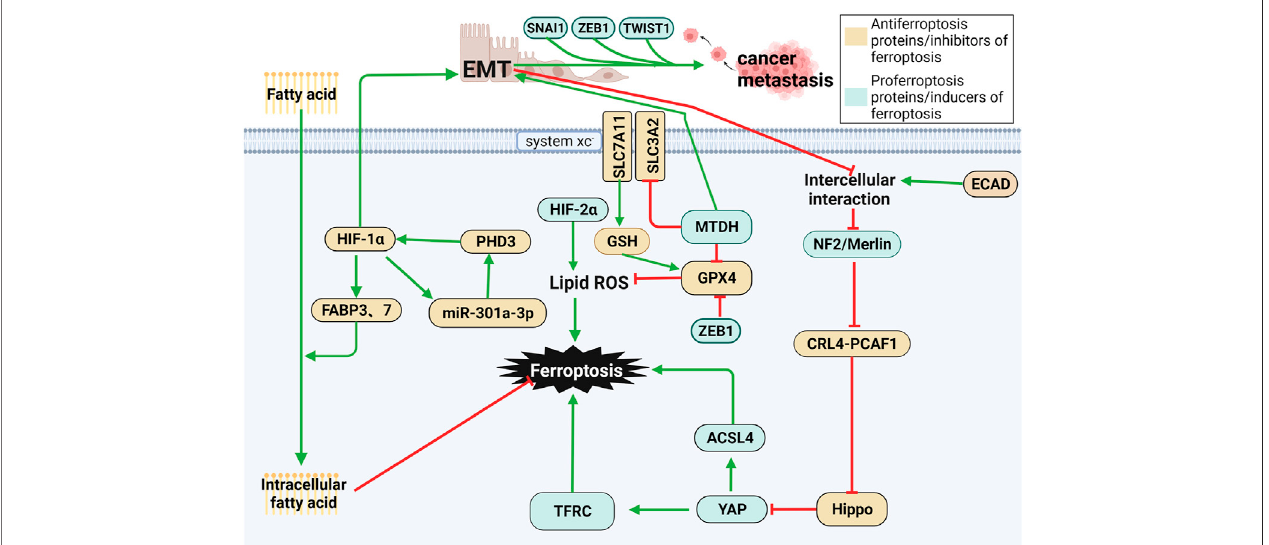
FIGURE 5 | Ferroptosis and cancer metastasis. (1) Various changes in the E-cadherin-Merlin-Hippo-YAP axis are associated with ferroptosis. When E-cadherin, Merlin,andHippoareinhibited,YAPisactivatedtofurtherinduceferroptosis,whileNF2/MerlinDe fi ciencydrivescancermetastasis. (2) EMTisfavorabletothesurvivalof cancer cells and metastasis, which blocks E-cadherin-induced cell – cell interactions and activates YAP, thus leading to ferroptosis. MTDH contributes to ferroptosis by reducingintracellularGSHlevelsbydownregulatingGPX4andSLC3A2. (3) HIFhasadualroleinregulatingferroptosisincancercells.ActivatedHIF-2 α upregulates lipid and iron-regulated genes and enhances lipid peroxidation ofPUFAs, thus enhancing their sensitivity to ferroptosis. In contrast, itprevents ferroptosis in cancer cells by improving the cellular uptake of fatty acids and lipid storage by upregulating FABP3 and FABP7.